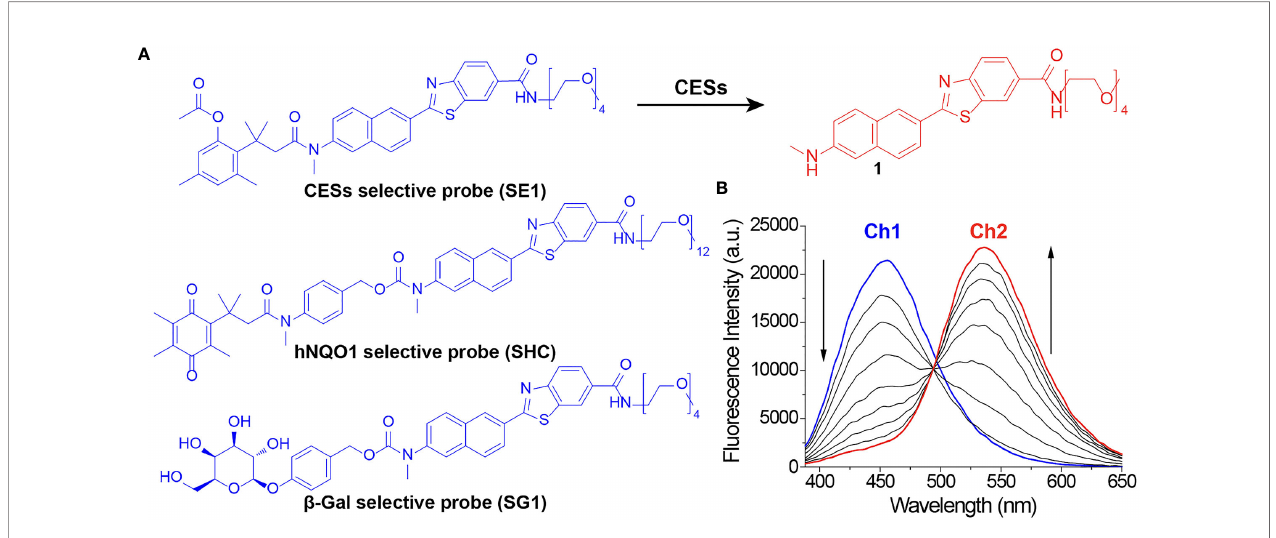
FIGURE 3 | (A) Chemical structure of two-photon probes and (B) fl uorescence spectrum change in SE1 because of structural